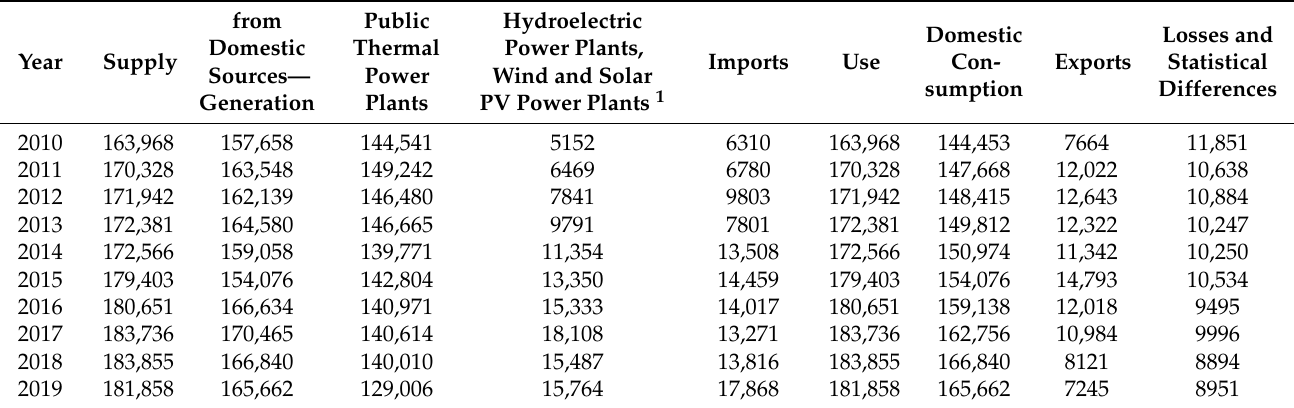
Table 4. Electricity balance (in GWh).